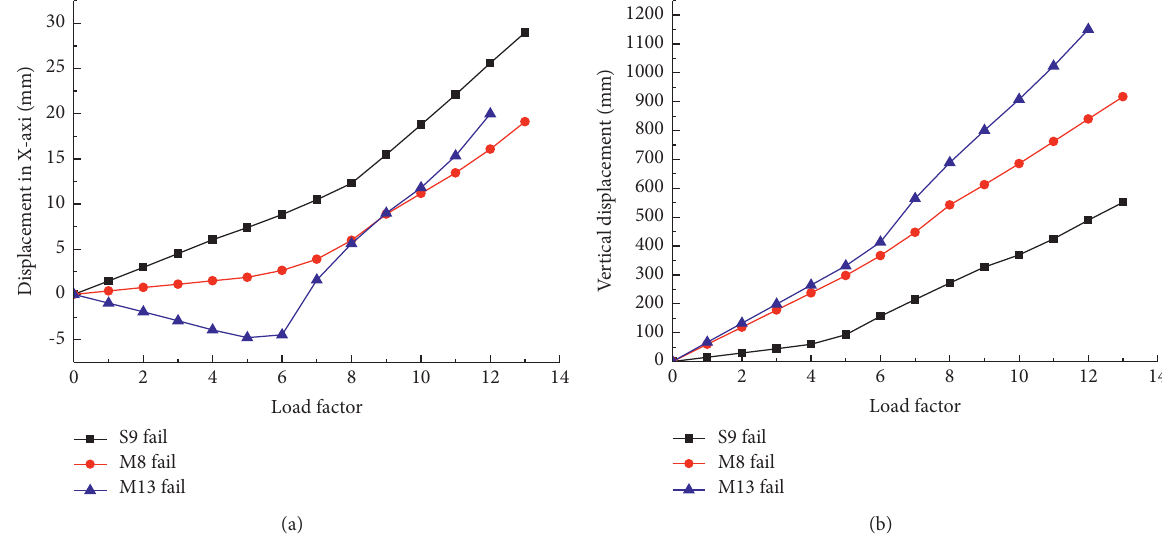
Figure 19: Displacement of the girder in the cable loss scenarios: (a) axial displacement-load response obtained from the finite element model; (b) vertical displacement-load response obtained from the finite element